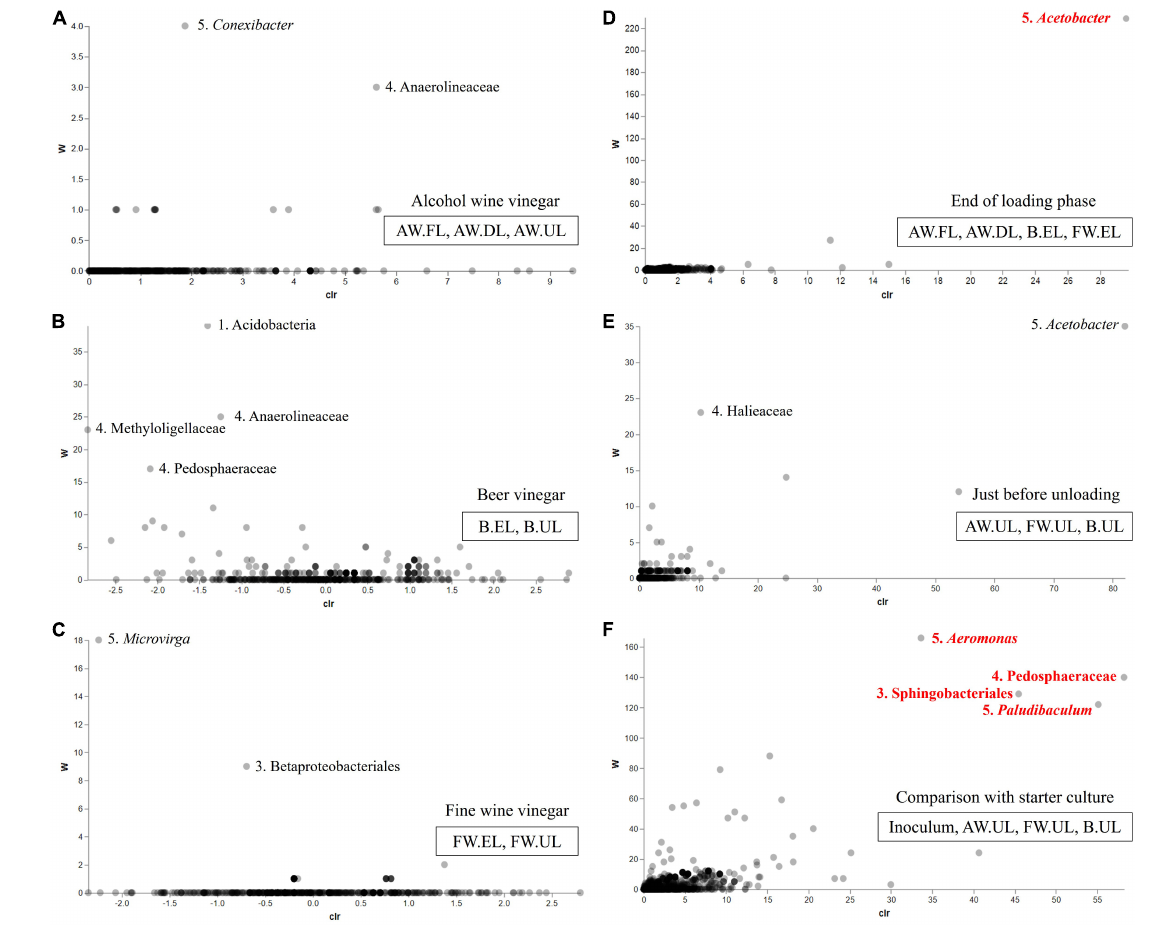
FIGURE8 Volcano plot which represents abundance differences of vinegar metagenome through the relationship of the ANCOM W statistic to the center-log-ratio (CLR) for the sample groups: (A) alcohol wine vinegar (AW.FL, AW.DL, AW.UL); (B) beer vinegar (B.EL, B.UL); (C) fine wine vinegar (FW.EL, FW.UL); (D) end of the loading phase (AW.FL, AW.DL, B.EL, FW.EL); (E) just before unloading (AW.UL, B.UL, FW.UL); (F) comparison with the starter culture (inoculum, AW.UL, B.UL, FW.UL). W statistic is the number of ANCOM null hypotheses rejected for each taxon, indicating significant differences between ratios of a taxon’s relative abundance to those of W for other taxa (FDR with a p -value < 0.05). Taxa are displayed as dots distributed along the matrix and numbers next to highlighted taxa indicate the taxonomical category (1. Phylum, 2. Class, 3. Orden, 4. Family, 5. Genus). Those taxa with significant abundance differences are displayed in red